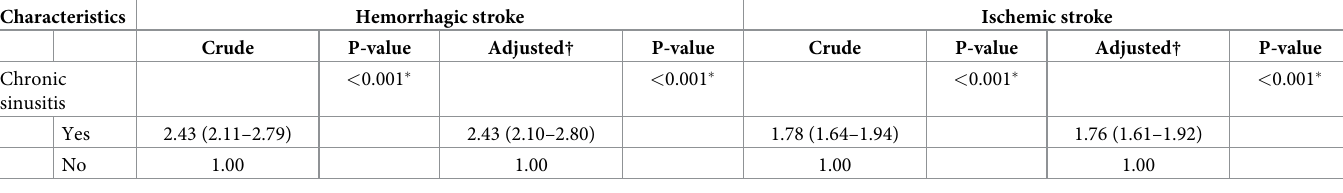
Table 2. Crude and adjusted hazard ratios (95% confidence interval) of chronic sinusitis for hemorrhagic stroke and ischemic stroke. Characteristics Hemorrhagic stroke Ischemic stroke